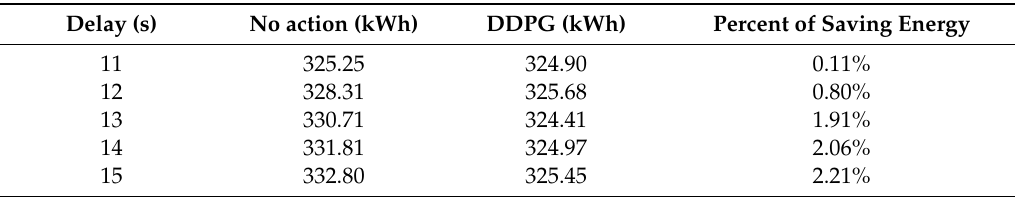
disturbances in the two-train network.